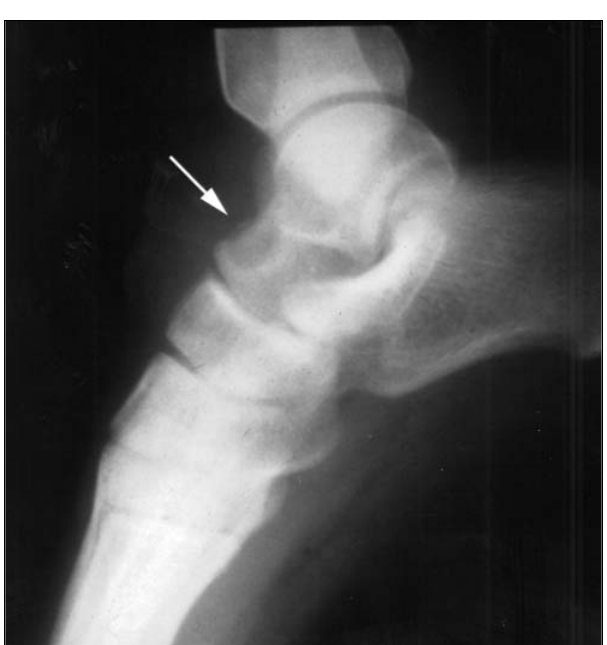
Figure 1) Radiograph of the left foot and ankle showing a sclerotic lesion in the anterior talus (arrow)